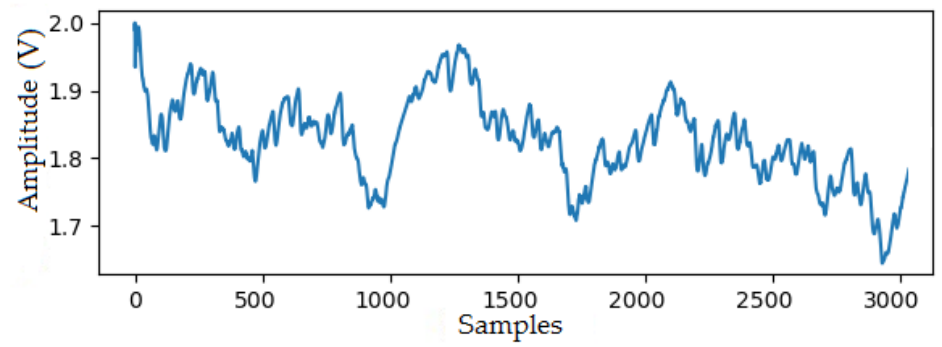
Figure 10. GSR signal from a participant in a stressed state.